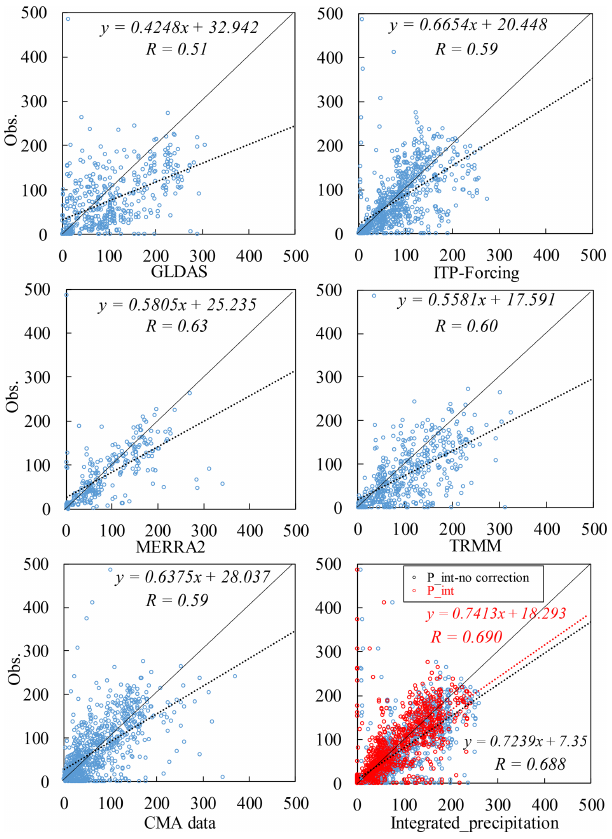
Figure 7. As for Fig. 6 but with scatterplots.